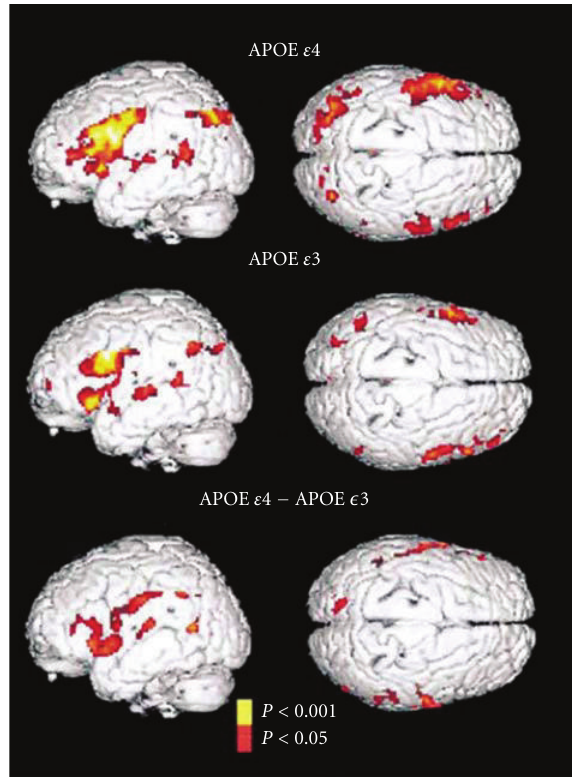
Figure 5: Statistical parametric maps of the brain used to assess subjects’ performance on memory-activation tests in carriers of the APOE ε 4 allele and carriers of the APOE ε 3 allele. The signal intensity increased significantly in the left inferior frontal region, the right prefrontal cortex, the transverse temporal gyri bilaterally, and the left posterior temporal and inferior parietal regions in both groups. However, both the extent and the intensity of activation were greater among the carriers of the APOE ε 4 allele. The carriers of the APOE ε 4 allele also had significant increases in the left parahippocampal, the left dorsal prefrontal cortex, and in the inferior and superior parietal lobes and the anterior cingulate gyrus. Direct comparisons of the carriers of the APOE ε 4 allele and the carriers of the APOE ε 3 allele (bottom panel, which shows the di ff erence between the carriers) further demonstrated the greater extent and magnitude of activity in the left prefrontal region and bilateral orbitofrontal, superior temporal, and inferior and superior parietal regions in the carriers of the APOE ε 4 allele (adapted with permission from